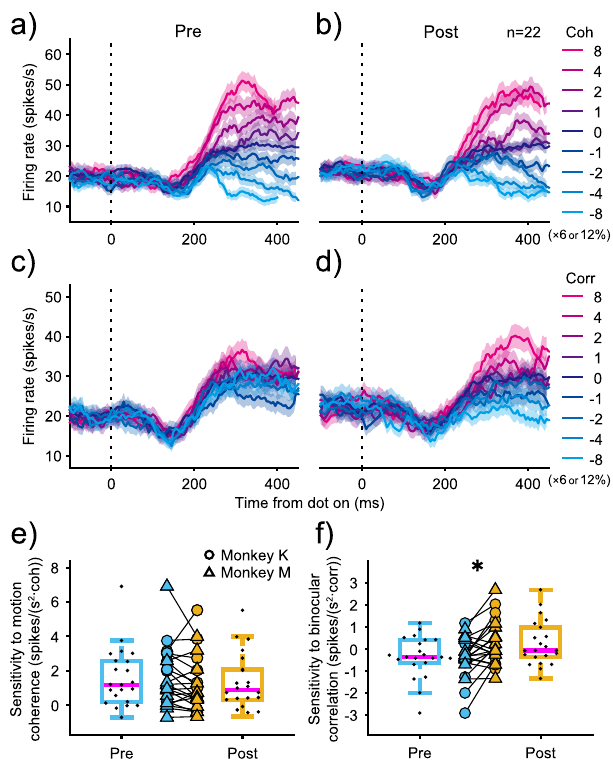
Fig. 4 Effects of ketamine on average LIP responses for the direction- discrimination task. Average fi ring rates across 22 LIP neurons aligned to visual stimulus onset are plotted before ( a ) and after ( b ) ketamine administration. Each colored line denotes fi ring rates at different motion coherence with binocular correlation fi xed at zero. Dotted-vertical line denotes the time of visual stimulus onset. Shaded area denotes SEM. c , d Each colored line denotes fi ring rates at different binocular correlation with motion coherence fi xed at zero. The conventions are the same as in ( a , b ). e , f LIP sensitivity derived from build-up slope before and after administration. Boxplots show the effects of ketamine on the sensitivity to motion coherence ( e ) and binocular correlation ( f ) for the direction- discrimination task. Boxplot conventions are the same as in Fig. 2. Circles and triangles denote each experimental data for monkey K and monkey M, respectively. Asterisks indicate statistically signi fi cant results (Wilcoxon signed-rank test; * p <